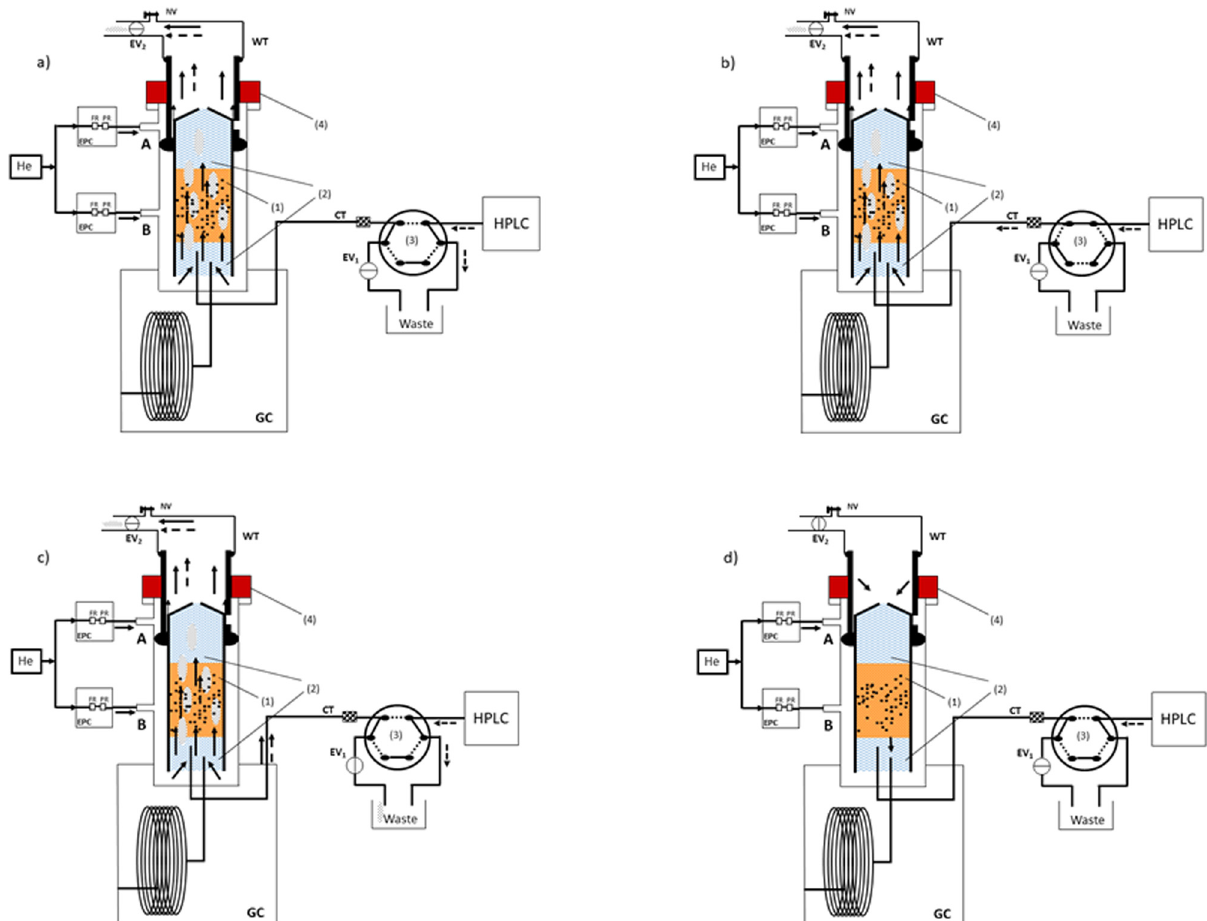
Figure 1: Scheme of the TOTAD interface during di ff erent steps: ( a ) stabilization, ( b ) injection ( in LVI ) or transfer ( in online LC - GC ) , ( c ) solvent elimination, and ( d ) desorption step. Symbols: 1, sorbent ( Tenax TA ) ; 2, glass wool; 3, six - port valve; 4, heated cover; EV1 and EV2, electrovalves 1 and 2; EPC, electronic pressure control; PR, pressure regulator; FR, fl ow regulator; solid arrows, gas fl ow; dotted arrows, liquid fl ow; CT, silica capillary tubing, 0.32 mm i.d.; WT, waste tubing; W, waste; , solvent; , analytes; NV , needle